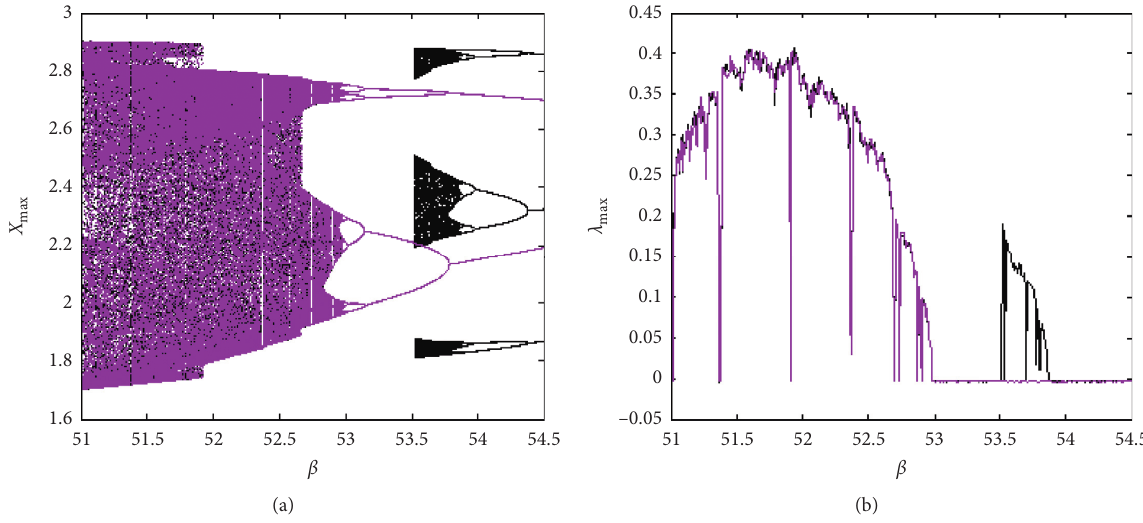
Figure 1: Bifurcation diagram (a) showing local maxima of coordinate x versus β and the corresponding graph (b) of the largest Lyapunov ) plotted in the range 51 ≤ β ≤ 54 . 5. Two sets of data are superimposed. The diagram in black is obtained when the control exponent ( λ max parameter is decreased from 54 . 5 to 51 starting with initial conditions ( 1 . 2 ; 0 ; 0 ) , while the one in magenta is obtained when decreasing the control parameter starting from the initial conditions ( 1 . 52 ; 0 ; 0 ) with α � 16 . 6.